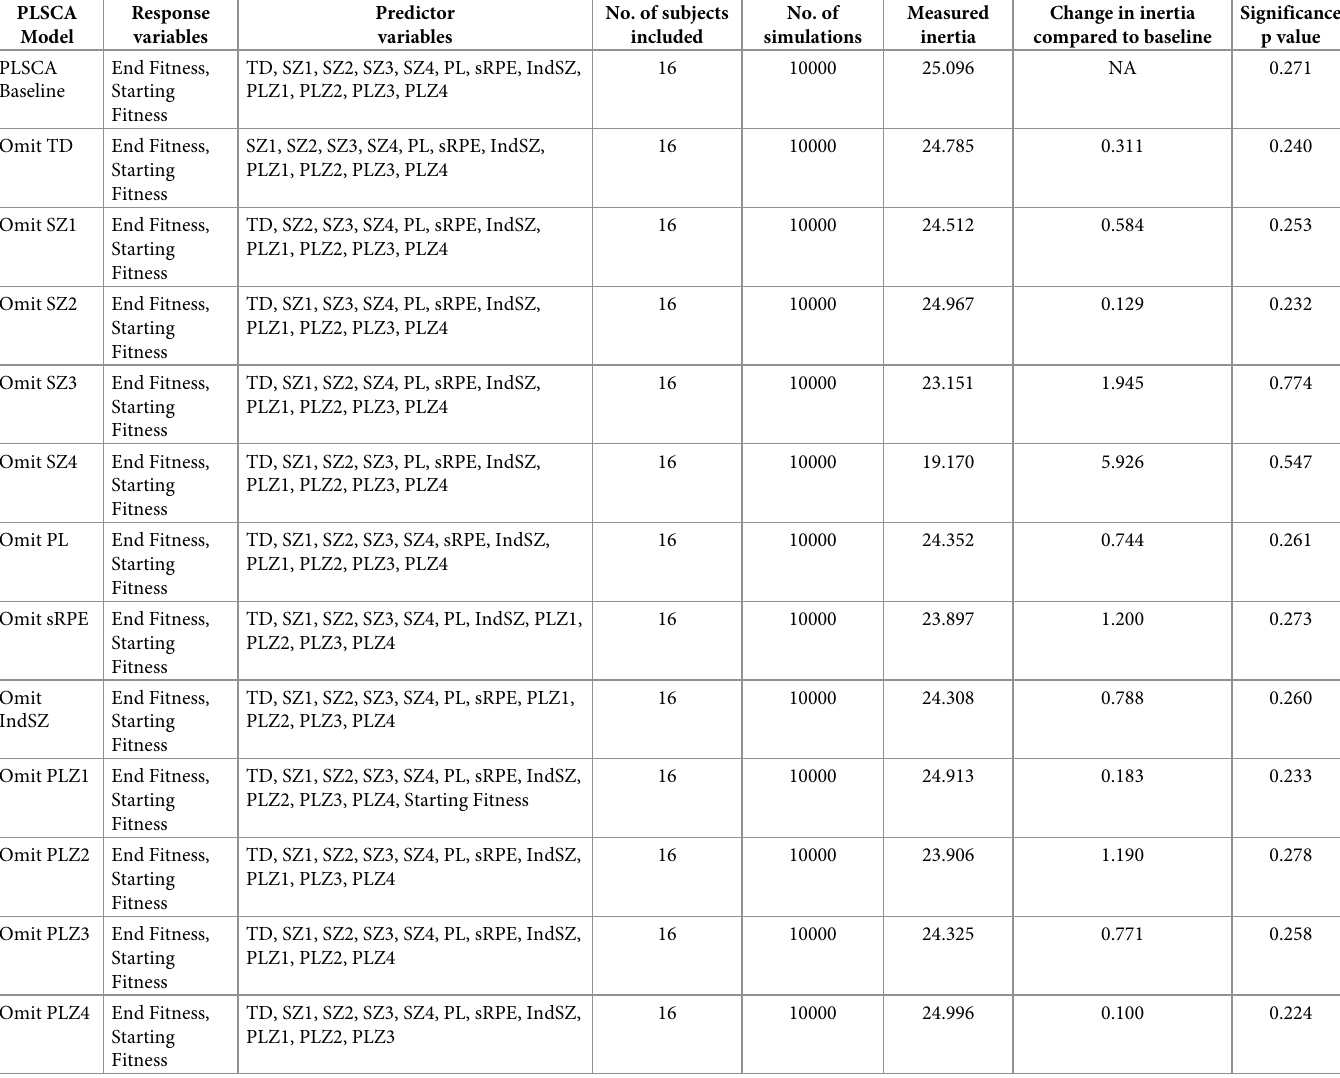
Table 5. Results of the LOVO PLSCA showing the effect on singular value inertia of omitting variables one at a time. PLSCA Response Model